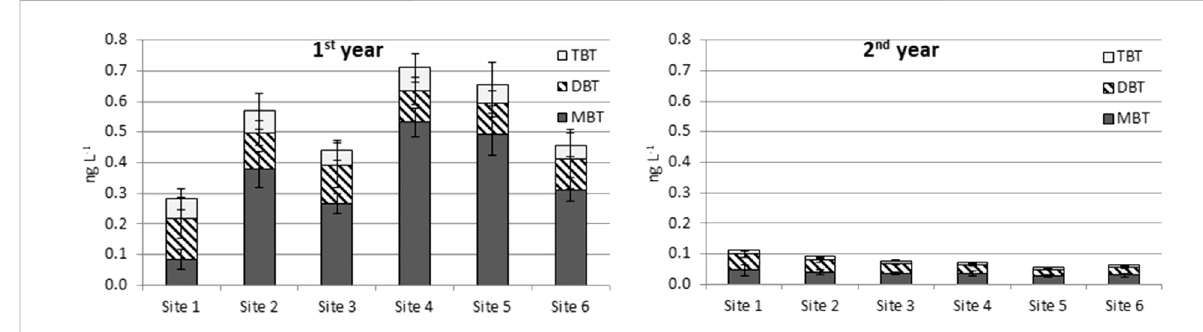
FIGURE 4 Average of MBT, DBT and TBT concentrations in Chemcatcher passive samplers.